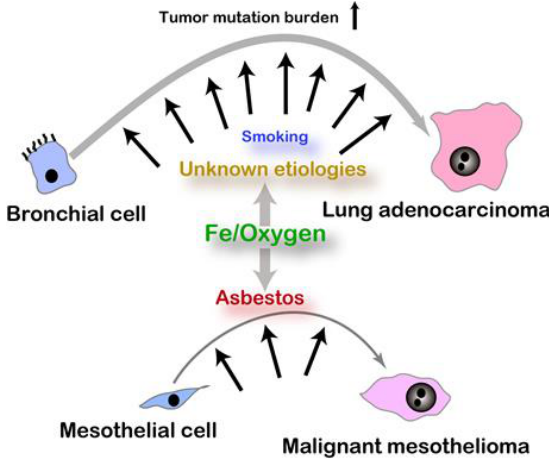
Figure 1. Etiology and somatic mutation burden in carcinogenesis. Asbestos exposure is a well-established risk for malignant mesothelioma whereas risks for lung adenocarcinoma with high somatic mutation burden are various and still vague.